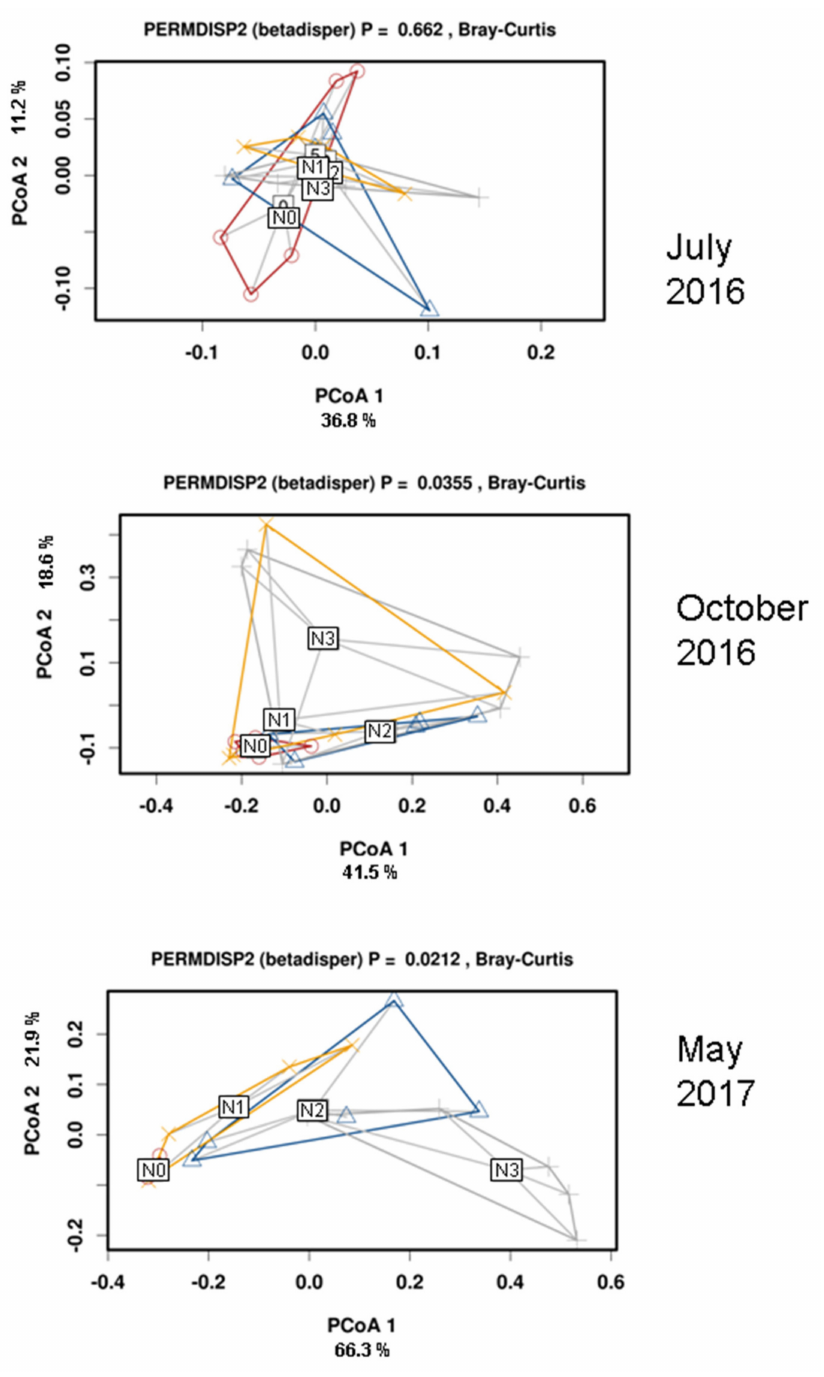
Figure 4. Differences in bacterial community composition among N treatments across different sam- pling times. PERMDISP2 visualizes the distances of each sample to the group centroid in a principal coordinate analysis (PCoA) and provides a p -value for the significance of the